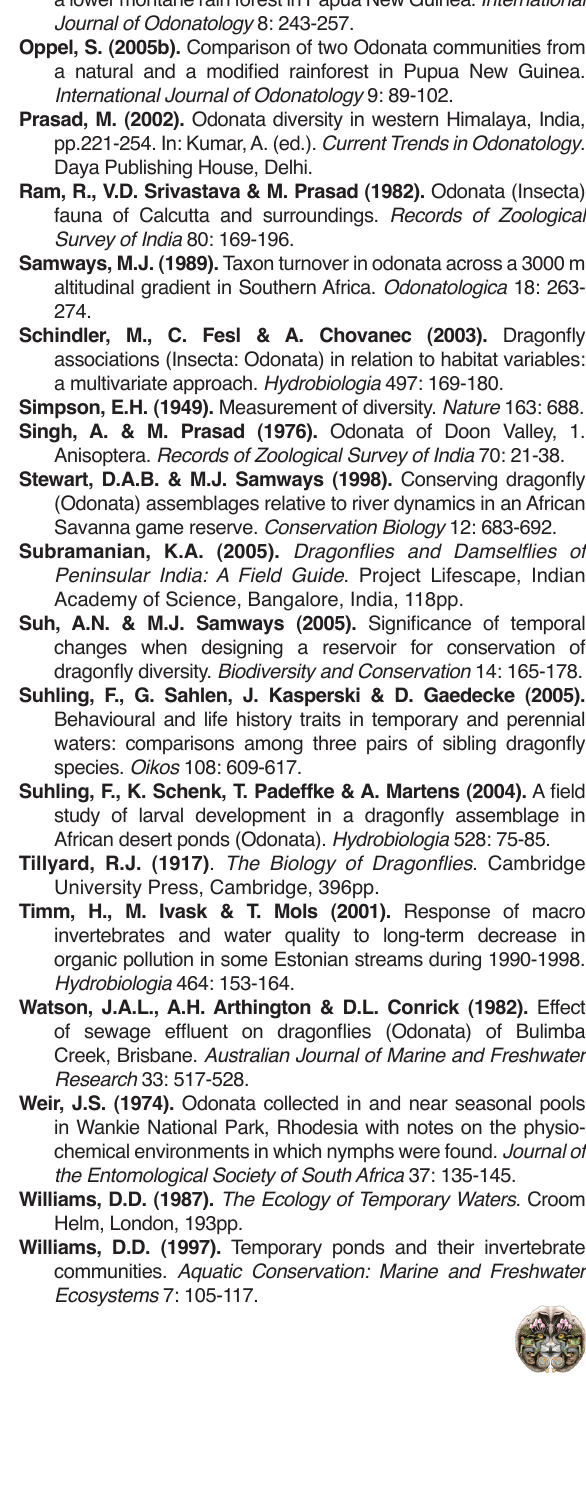
Table 3. Species diversity (Simpson) of Odonata in temporary water bodies of Tamil